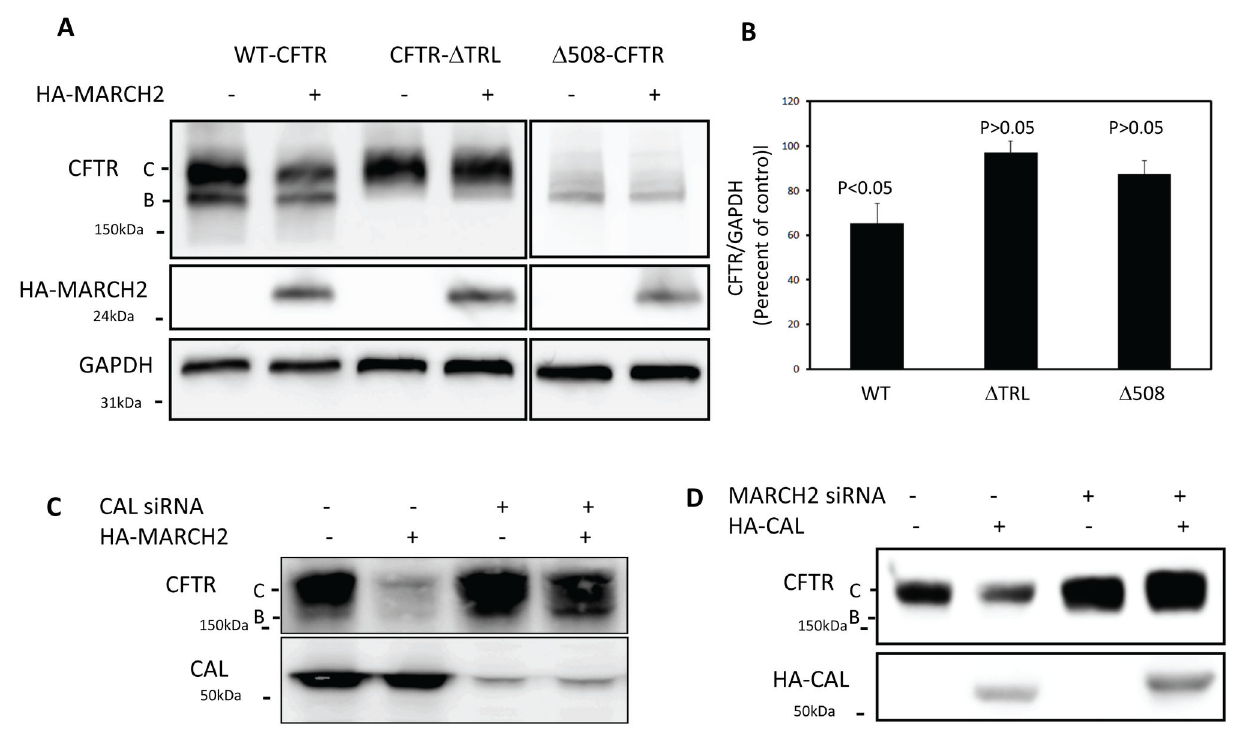
Figure 6. Degradation of wild-type CFTR, but not Δ TRL or Δ508 CFTR, by MARCH2. ( A ) HEK293 cells were co-transfected with 3 µg GFP-tagged wild-type (WT), ΔTRL, or Δ508 CFTR and 1µg HA-MARCH2 as indicated. After 48 h, cell lysates were harvested and subjected to immunoblot analysis. ( B ) Densitometric analysis of CFTR in (A). CFTR is normalized to GAPDH. Values are presented as mean +/- S.E. ( C ) HEK293 cells were first transfected with 20 nM CAL siRNA. After 24 h, the cells were transfected with 3µg pCMV-CFTR, with or without 1µg HA-MARCH2, as indicated. At 48 h after the second transfection, cell lysates were collected and subjected to SDS-PAGE and immunoblot analysis with the indicated antibodies. ( D ) HEK293 cells were first transfected with 20 nM MARCH2 siRNA. After 24 h, the cells were transfected with 3µg pCMV-CFTR, with or without 3µg HA-CAL, as indicated. At 48 h after the second transfection, cell lysates were collected and subjected to SDS-PAGE and immunoblot analysis with the indicated antibodies. Data shown are representative of at least three independent